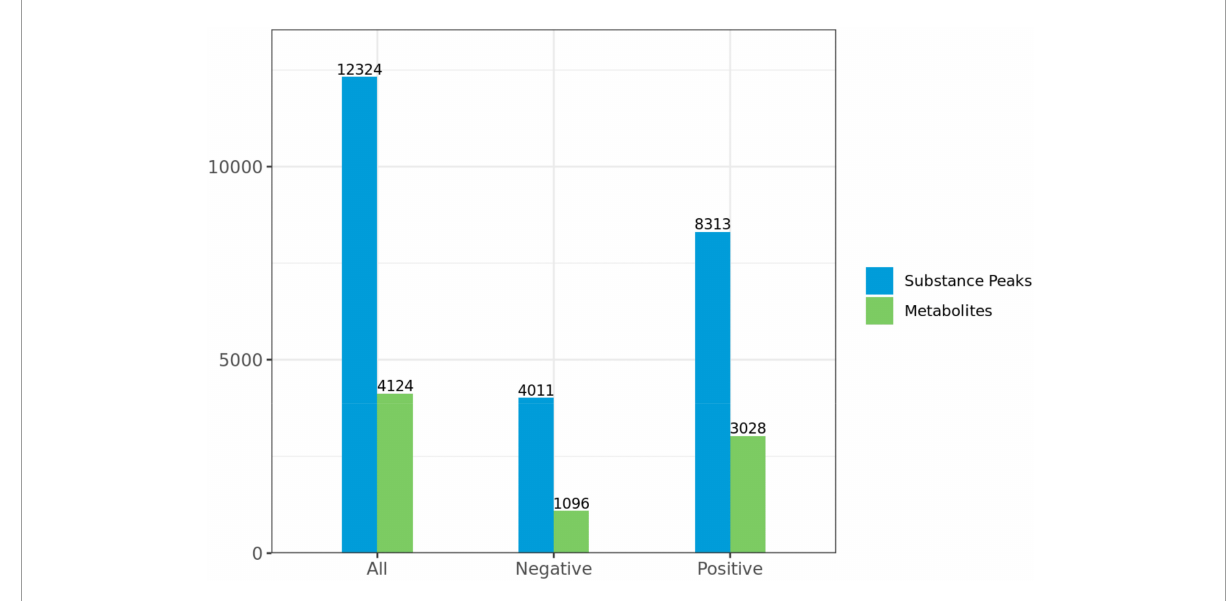
FIGURE4 Statistics of substance peaks and